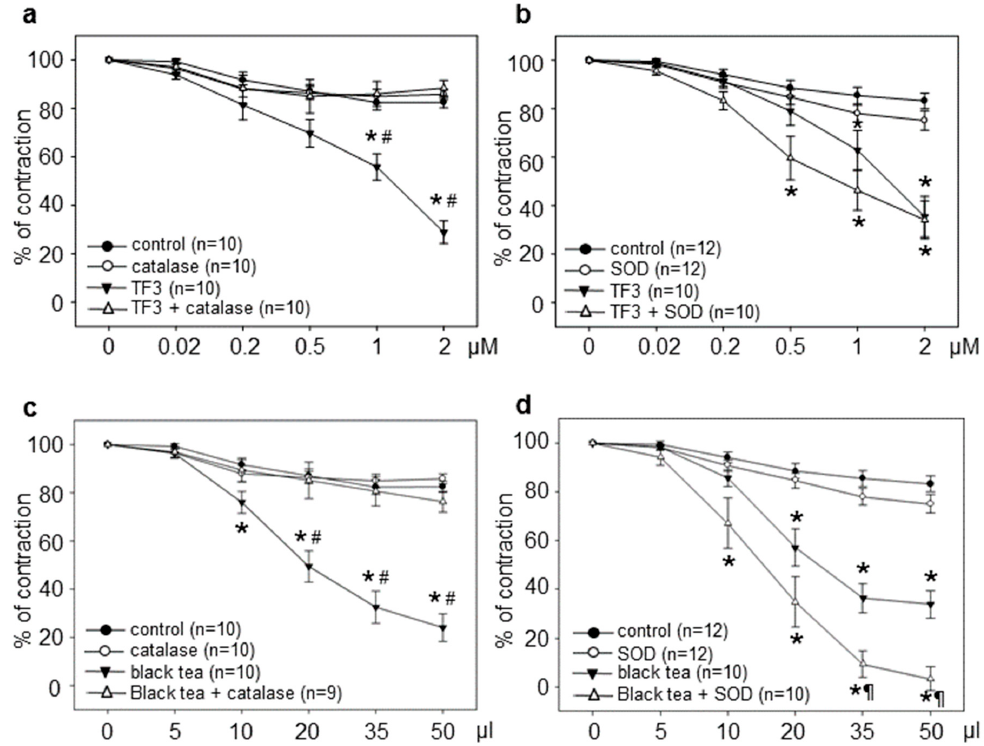
Figure 2. Catalase but not SOD prevented black tea polyphenol-induced vasorelaxation. Vasorelaxation was stimulated with cumulative doses of theaflavin-3,3'-digallate (TF3) ( a,b ) or black tea ( c,d ) with or without 200 U/mL catalase or 500 U/mL superoxide dismutase (SOD). Graphs show relaxation expressed as the percentage of maximal phenylephrine-induced vasoconstriction. Control rings received the same amount of water (control) or antioxidant enzymes alone. Data are means ± SEM of the indicated number of experiments. * p < 0.05 compared to the control; # p < 0.05 compared to treatment + catalase; ¶ p < 0.05 compared to black tea.